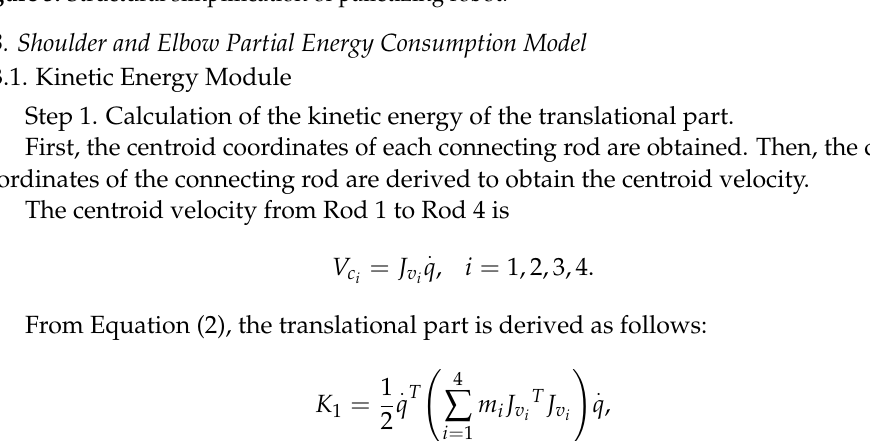
Figure 3. Structural simplification of palletizing